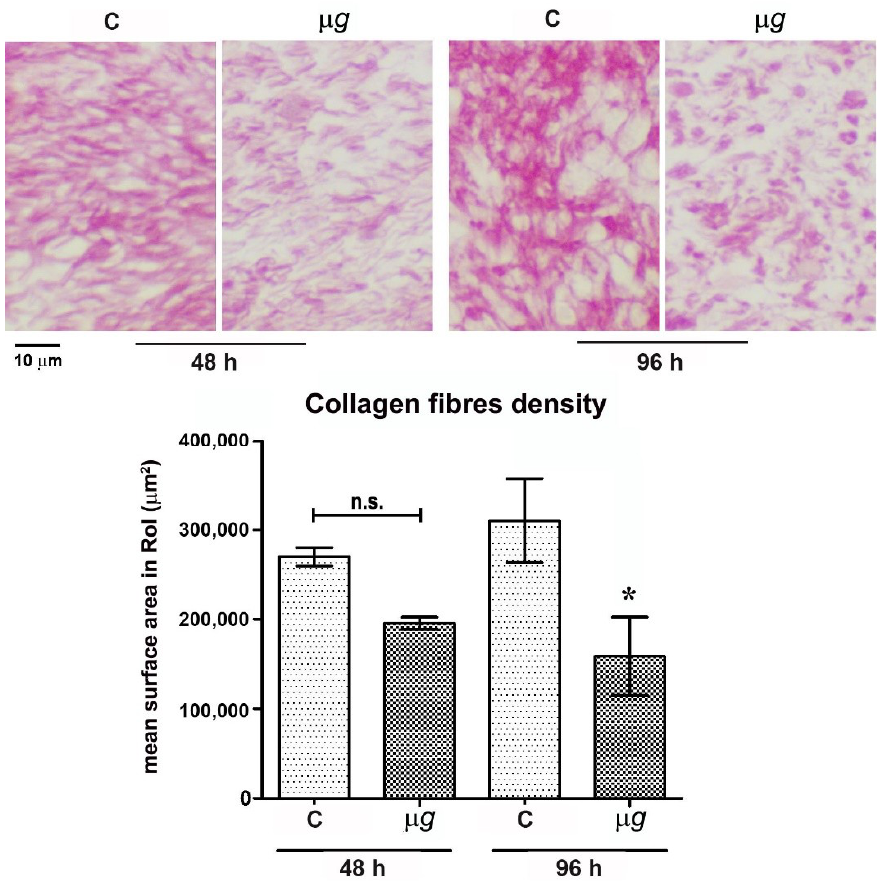
Figure 2. Effect of modeled μg on in vivo model of sutured wound healing ( Hirudo medicinalis ): collagen fibres content in the connective tissue at the wound site. Light microscopical features and morphometric quantitation of picrosirius red-stained collagen fibres at the wound site after 48 h and 96 h exposure to modeled μg . C = 1 × g controls; * p < 0.05 vs. C-96 h ( n = 3); n.s. = not significant.